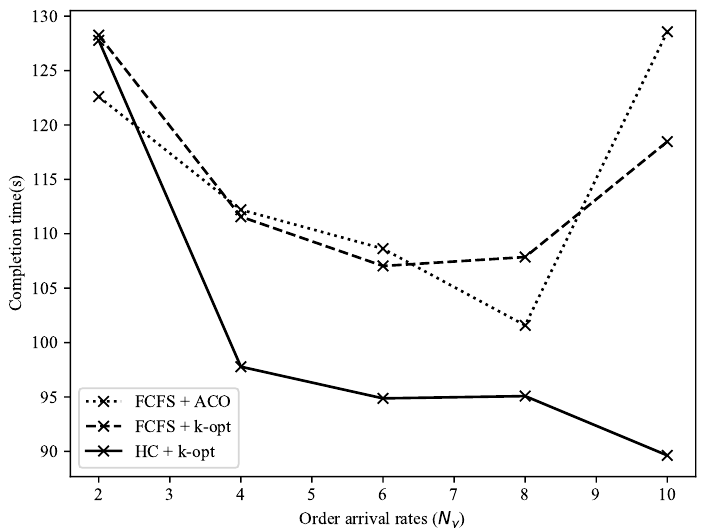
Figure 6. Comparison graph of completion time by algorithm for order arrival rate. For online ordering, the distribution of travel distances of multi-UAVs by algorithm is expressed in the form of a box plot in Figure 7. The FCFS + ACO and the FCFS + k-opt used different order sequencing algorithms, but the UAVs to which the two algorithms are applied have similar average moving distances. Furthermore, in Figure 6, the application of k-opt with a fast operation speed affects the reduction of the completion time of the warehouse operation. The HC + k-opt method shows a box plot with a lower travel distance compared to other algorithms. In the proposed method, the overall travel distance is low and evenly distributed because the UAVs are processed in consideration of the similarity of online orders. This reduction in the moving distance of the multi-UAVs saves on the moving cost of the UAV. The saved moving cost contributes to increasing the operating time of UAVs with limited batteries in the warehouse [33].